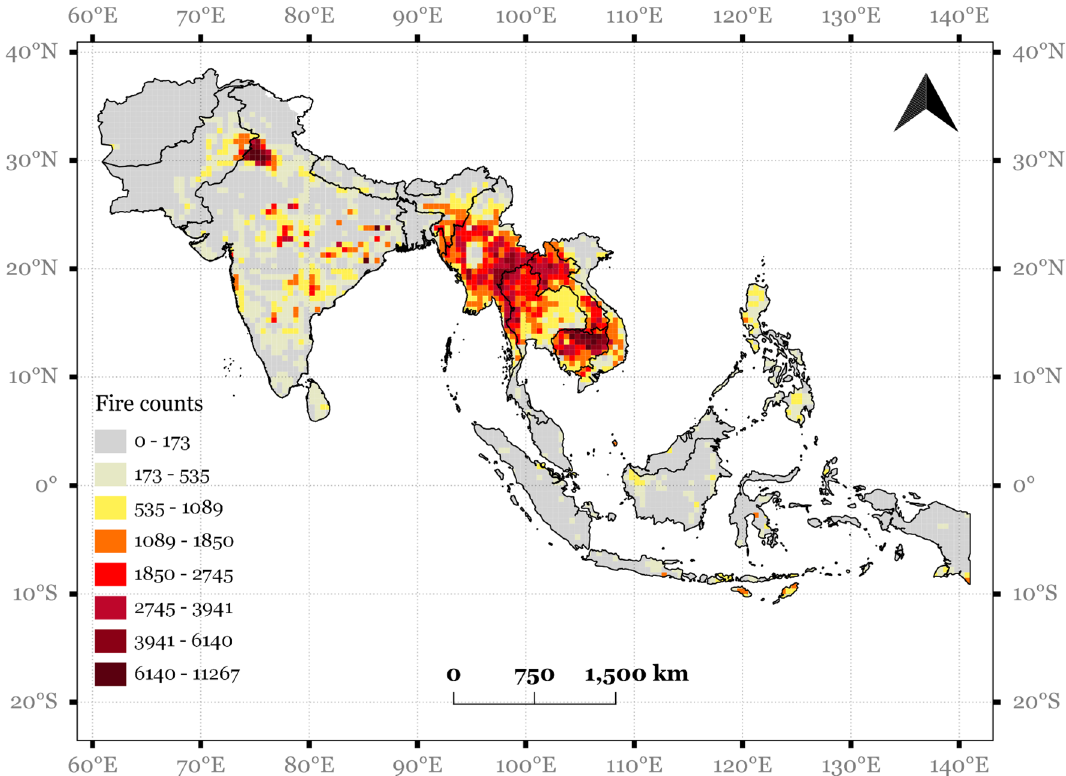
Figure 7. Fire counts (FC) for 2020 pandemic year derived from VIIRS fire data (Map created using QGIS